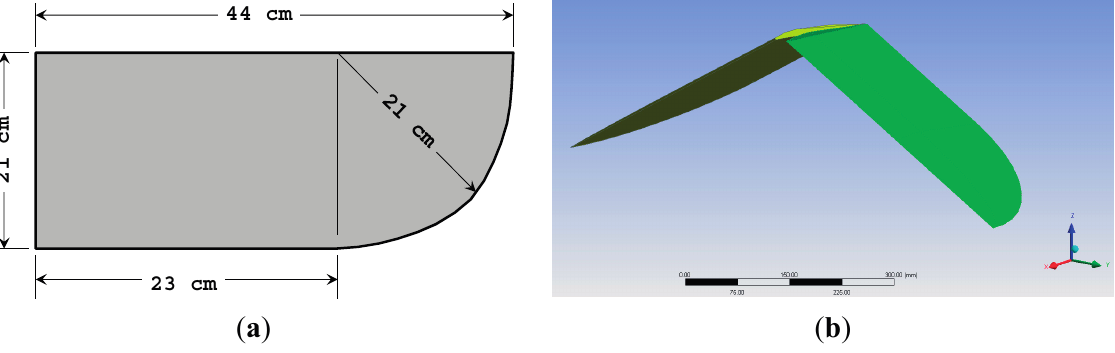
Figure 7. ( a ) Simplified albatross flapping model with detailed geometry; ( b ) The wing is shown at − 15 flapping position about its body ( X )